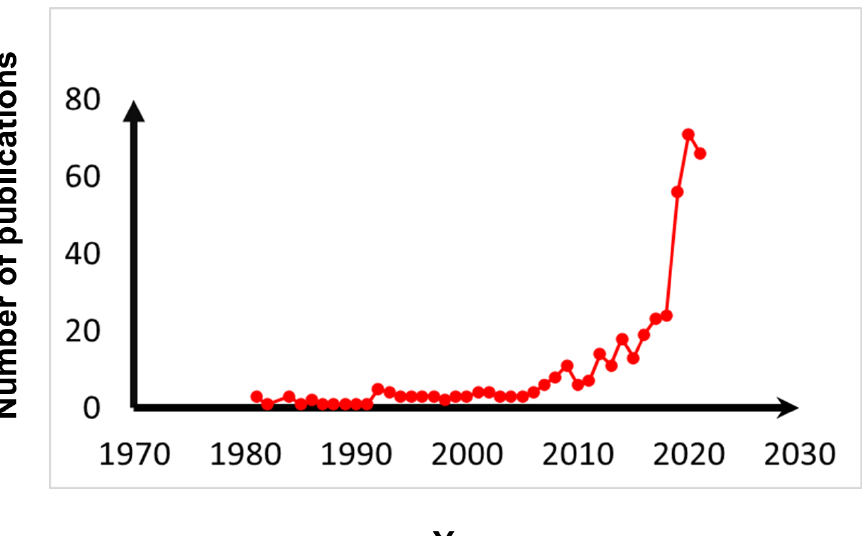
Figure 3. The numbers of publications regarding natural compounds used in PDT.